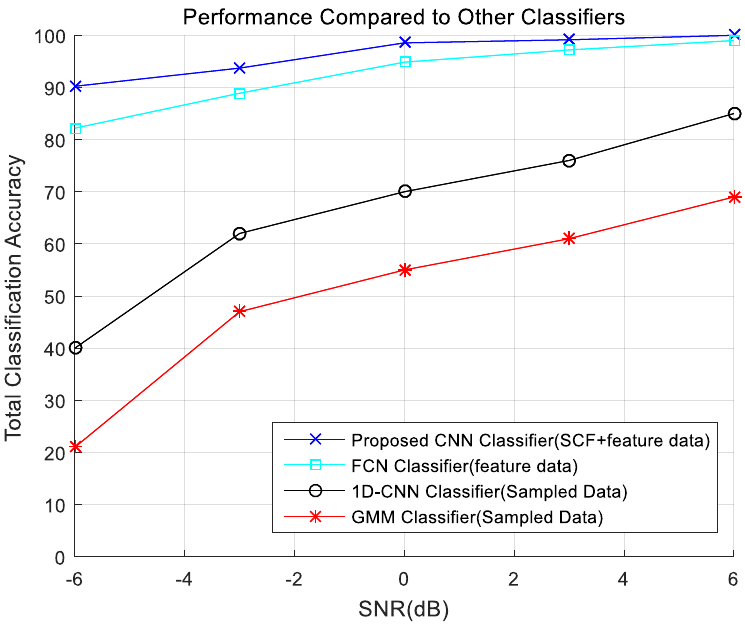
Figure 12. Modulation type classification for various signal-to-noise ratio (SNR) conditions. Table 3. Classification accuracy for different modulation types at low SNR (SNR = − 6 dB).